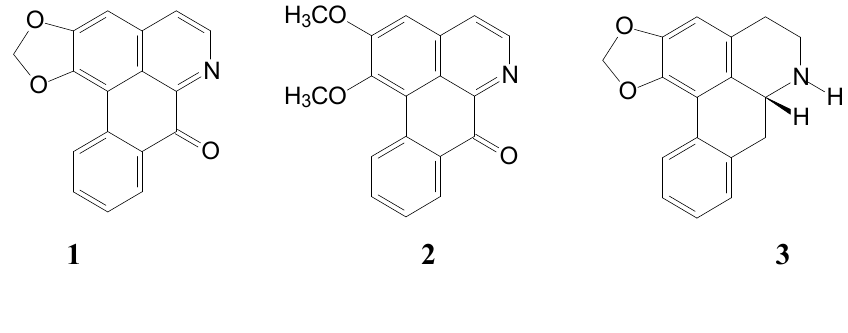
Figure 1. Structures of alkaloids 1 – 11 isolated from the leaves of N. nucifera